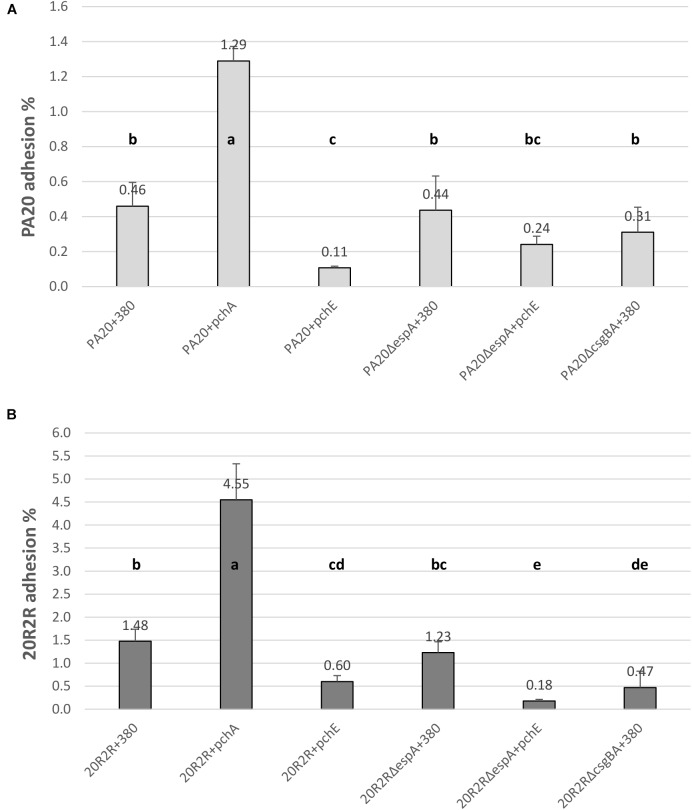
Comparison of the effect of HTR regulators PchA and PchE on the adhesion of E. coli O157:H7 strain PA20 and 20R2R to HEp-2 cells. Percentage of adhered wild-type, ΔespA, and ΔcsgBA PA20 (A) and 20R2R (B) transformed with control plasmid pSE380 or pSE380 carrying pchA or pchE regulators to HEp-2 cells following 3 h exposure at 37°C in 5% CO2. Bars represent the mean adhesion percentage ± SD of four independent samples. Any two treatment means with no letter in common are significantly (P < 0.05) different by the Bonferroni LSD method.